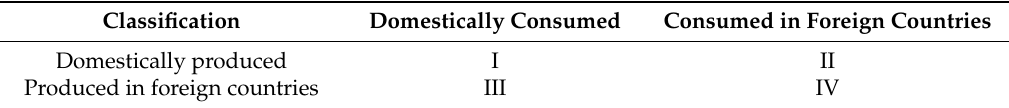
Table 1. Four categories of embodied CO 2